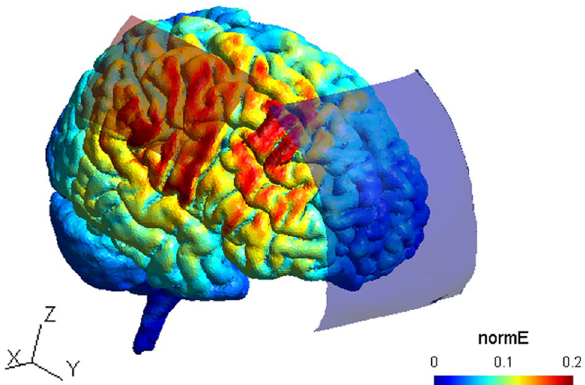
Figure 5. TDCS current flow simulation. Anode is depicted as red rectangle and cathode as blue rectangle projected on a standard head model. Normalized electrical field strength (V/m) is indicated through colormaps with blue representing lowest and red representing highest field strengths, respectively. The current flow image was created using the SIMNIBS software version 3.1.2 100